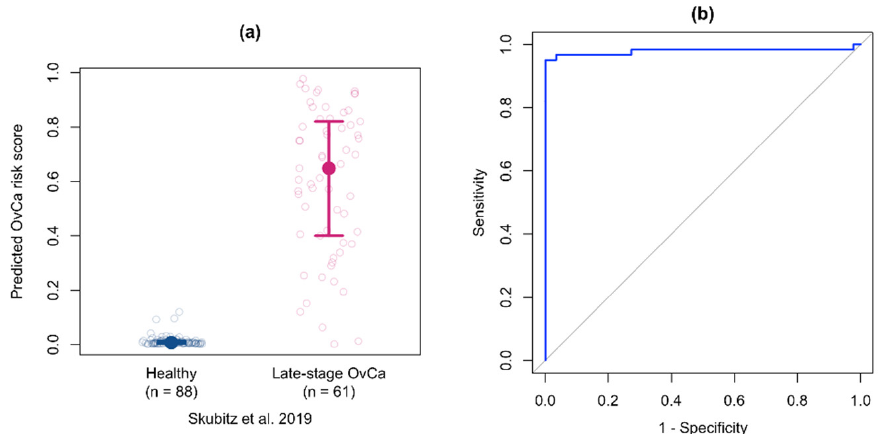
Figure 6. Validation of the multiprotein classifier with serum samples from women with late stage ovarian cancer. ( a ) Predicted cancer risk scores with median and 25th and 75th percentiles stratified by true cancer status for late stage ovarian cancer samples ( n = 61 cancer samples; n = 88 healthy controls) from Skubitz et al. [12]. ( b ) ROC curve for the early stage multiprotein classifier applied to the late stage samples.